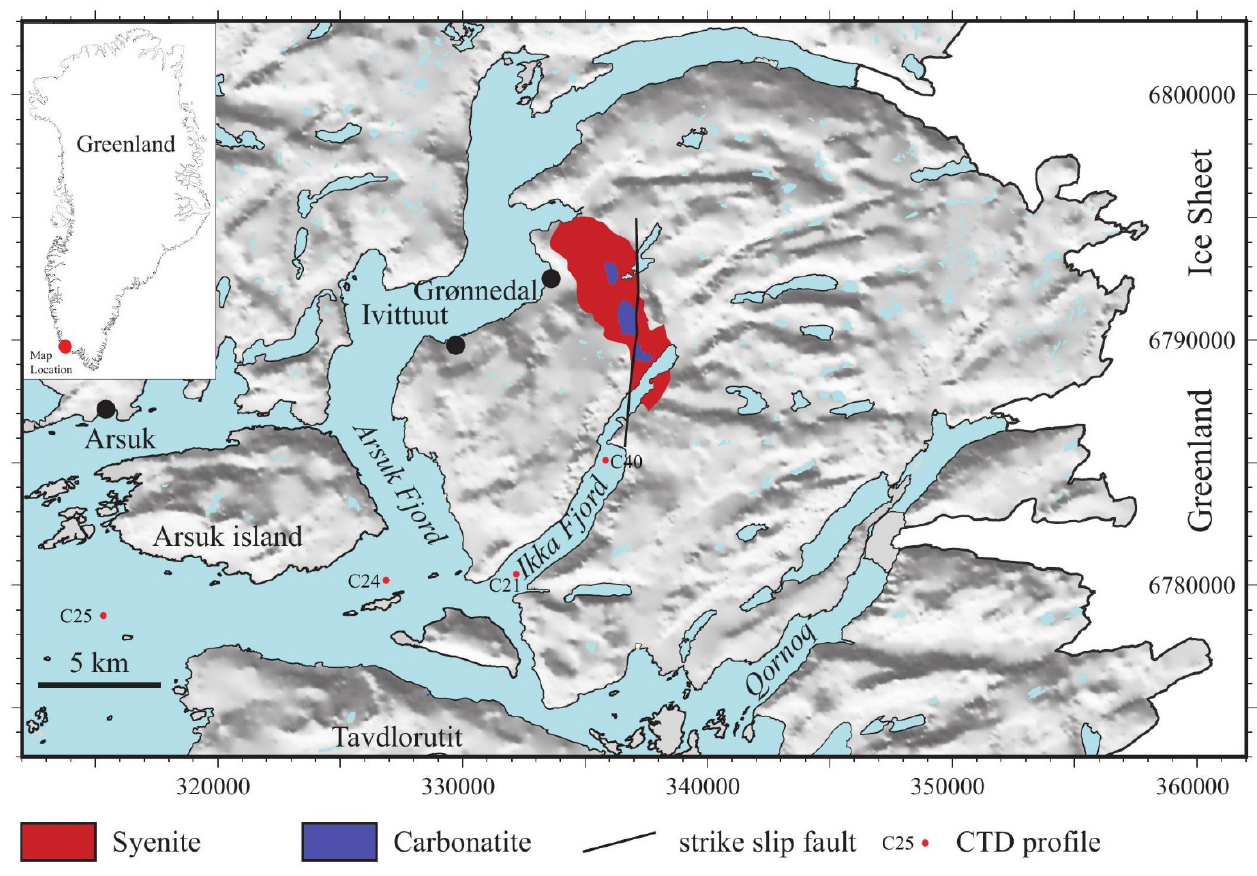
Figure 1. Location of Ikka Fjord in Greenland. Red and blue-coloured areas mark the Grønnedal- Íka igneous complex, and grey areas consist of old Archean gneissic rocks.